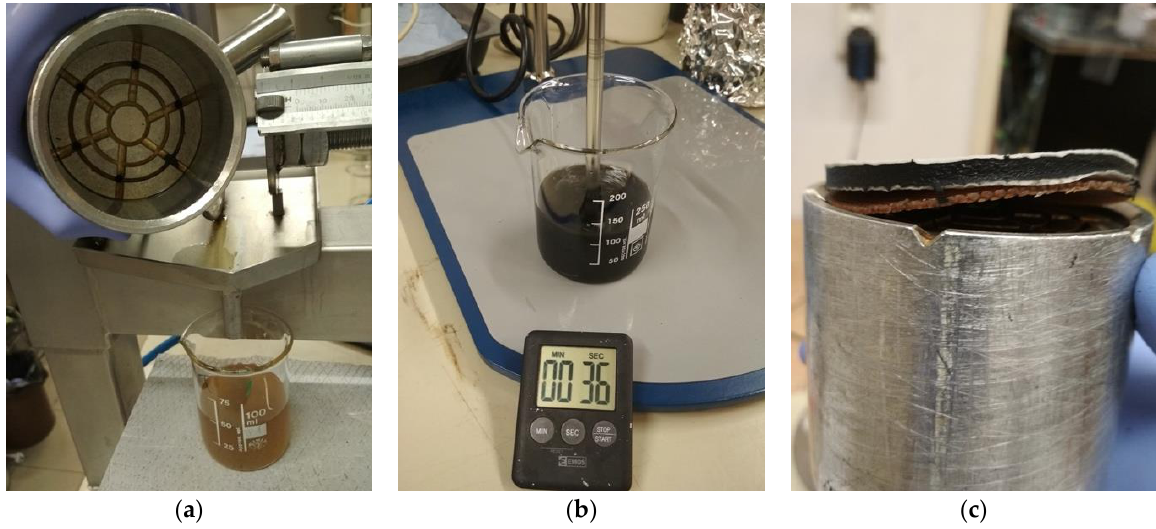
Figure 3. Digestate dewatering by mechanical pressing: ( a ) digestate with flocculant dosage; ( b ) mixing at 700 rpm for 3 min; ( c ) dewatered digestate.